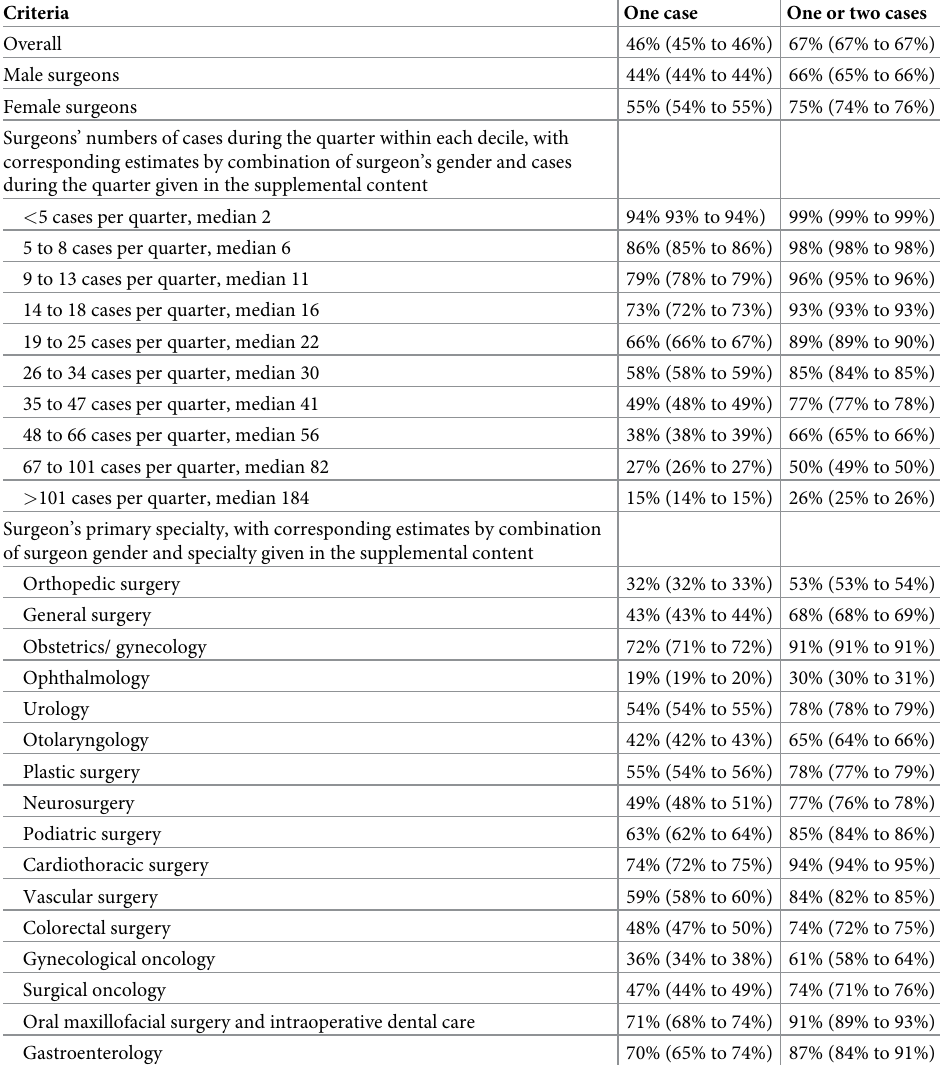
Table 3. Percentages of lists of cases that included one case or one or two cases, with 99% confidence intervals a,b . Criteria One case One or two cases Overall 46% (45% to 46%) 67% (67% to 67%) Male surgeons 44% (44% to 44%) 66% (65% to 66%) Female surgeons 55% (54% to 55%) 75% (74% to 76%) Surgeons’ numbers of cases during the quarter within each decile, with corresponding estimates by combination of surgeon’s gender and cases during the quarter given in the supplemental content < 5 cases per quarter, median